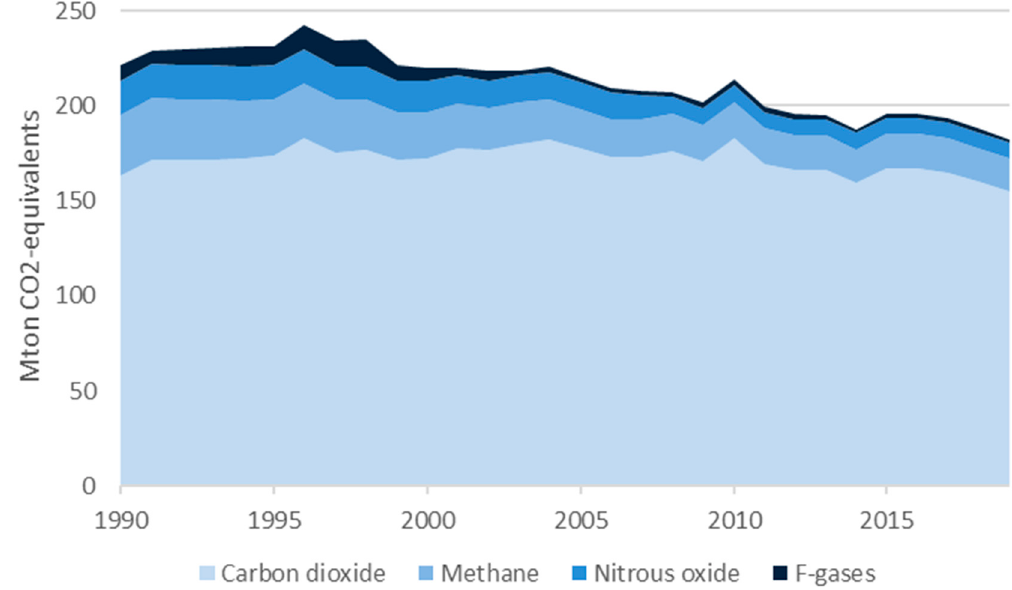
Figure 1. Greenhouse gas emissions development in the Netherlands 1990 – 2019. Derived from [7].